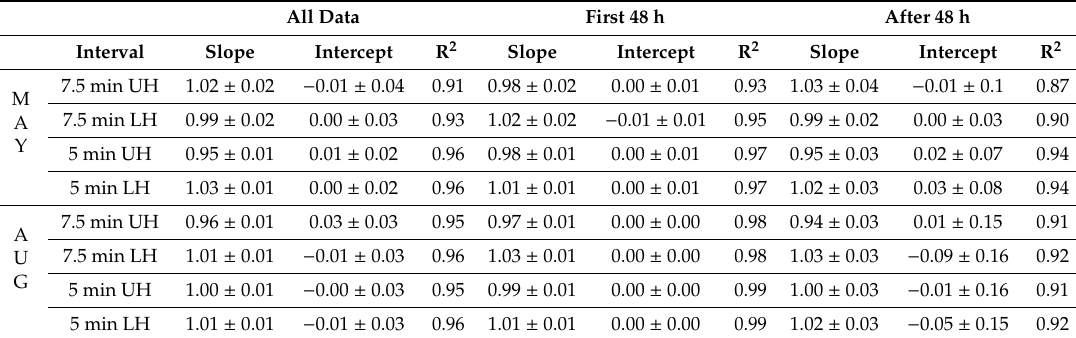
Figure 2. Scatter plot of simulated fluxes as a function of the AGM flux in ( a ) May and ( b ) August. The blue line represents 1:1 vertical line. Regression variables are shown in Table 4. Table 4. Linear regression data from the cross-correlation plots, Figure 2, where the simulated flux is a function of the AGM flux. R 2 is the coefficient of determination.